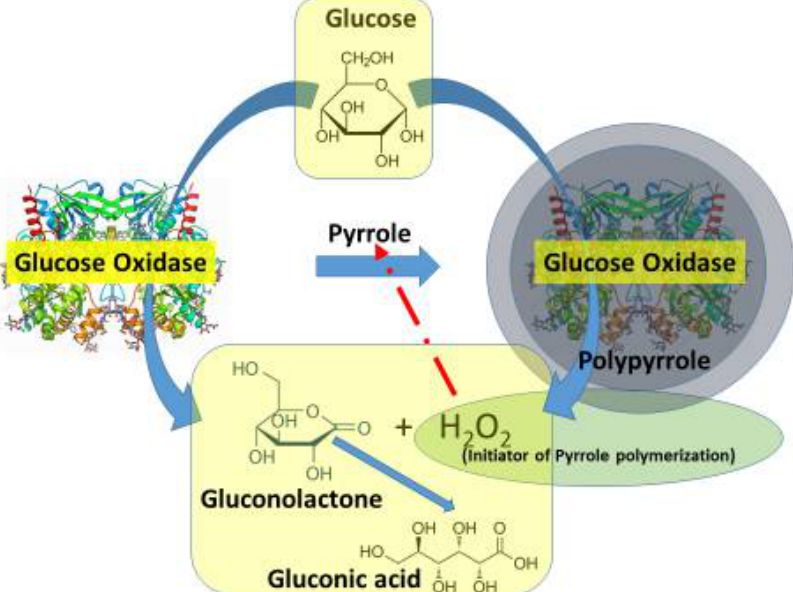
Figure 1. Enzymatic formation of polypyrrole around enzyme glucose oxidase, which, during catalytic action, generates H 2 O 2 that acts as an initiator of pyrrole polymerization reaction. Microbiological synthesis of polypyrrole. The application of microorganisms in the synthesis of conducting polymers offers even more advantages in comparison with the application of isolated enzymes, because microorganisms can retain their activity during the long-lasting life cycle of single microorganism and/or culture based on high number of micoorganisms [42]. Hence, microorganisms have been used for the synthesis of some polymers [43]. Recently, our research team applied whole microorganisms for the synthesis of conducting polymer polypyrrole. In the initial research, which has reported bacteria- assisted synthesis of polypyrrole, we used bacterial cells Streptomyces spp., which produce some phenol-oxidases; therefore, these enzymes are able to perform polymerization of pyrrole by forming Ppy-based hollow Ppy microspheres [44]. In another research, we applied living cell induced redox cycling of [Fe(CN) 6 ] 4 − /[Fe(CN) 6 ] 3 − , which enabled the formation of polypyrrole within the yeast cell wall [45]. We demonstrated that these kinds of Ppy formation redox processes, which are involved in metabolism occurring in living cells, can be adapted even without any redox mediators [46]. Our studies based on the nonradioactive isotope method illustrated that Ppy formed during microbial polymeriza- tion is deposited mainly within the cell wall and in the space between the cell wall and cell membrane